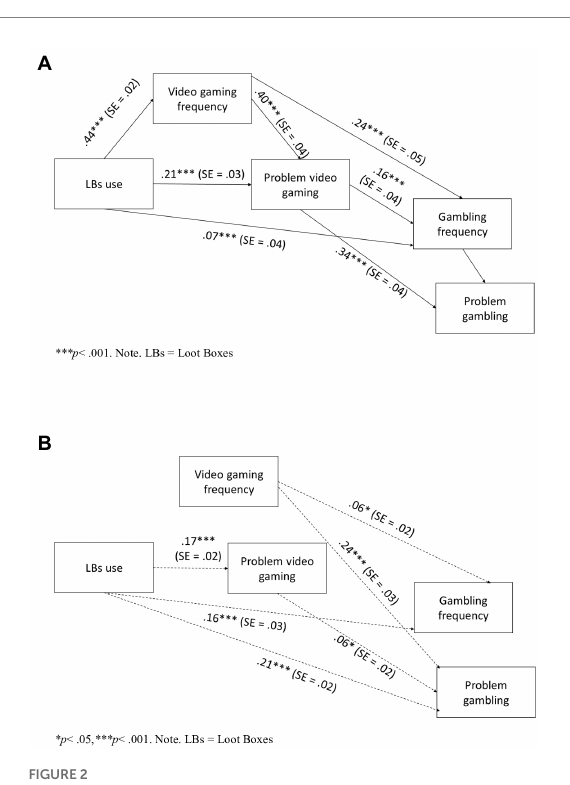
FIGURE 2 (A) Path model with direct effects among the variables in Study 6. (B) Path model with indirect effects among the variables in Study